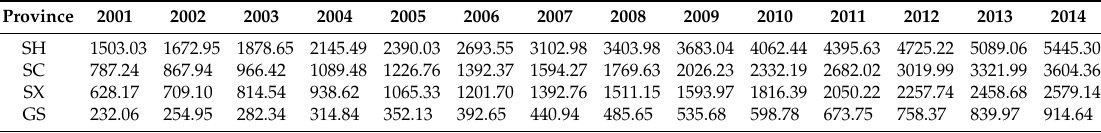
Table 7. The annual gross benefits from utilization of electricity in SH, SC, SX, and GS (10 8 CNY). Province